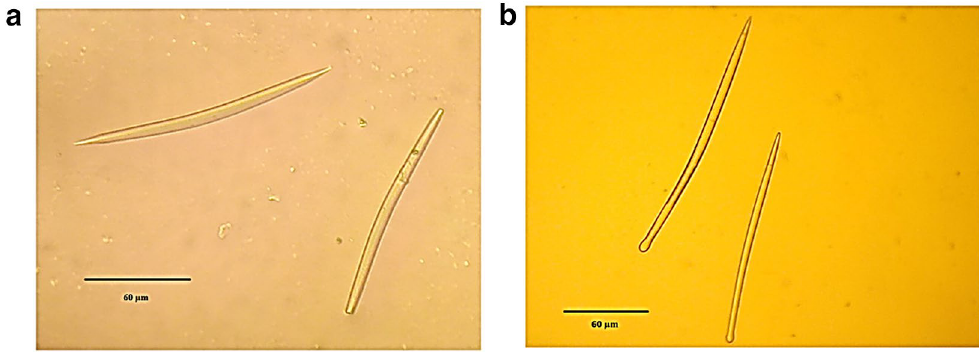
Figure 1. Spicule morphology of sponges Gelliodes pumila ( a ) and Cliona lobata ( b ) . G. pumila shows characteristic oxeas spicule morphology and C. lobata shows characteristic tylostyle spicule